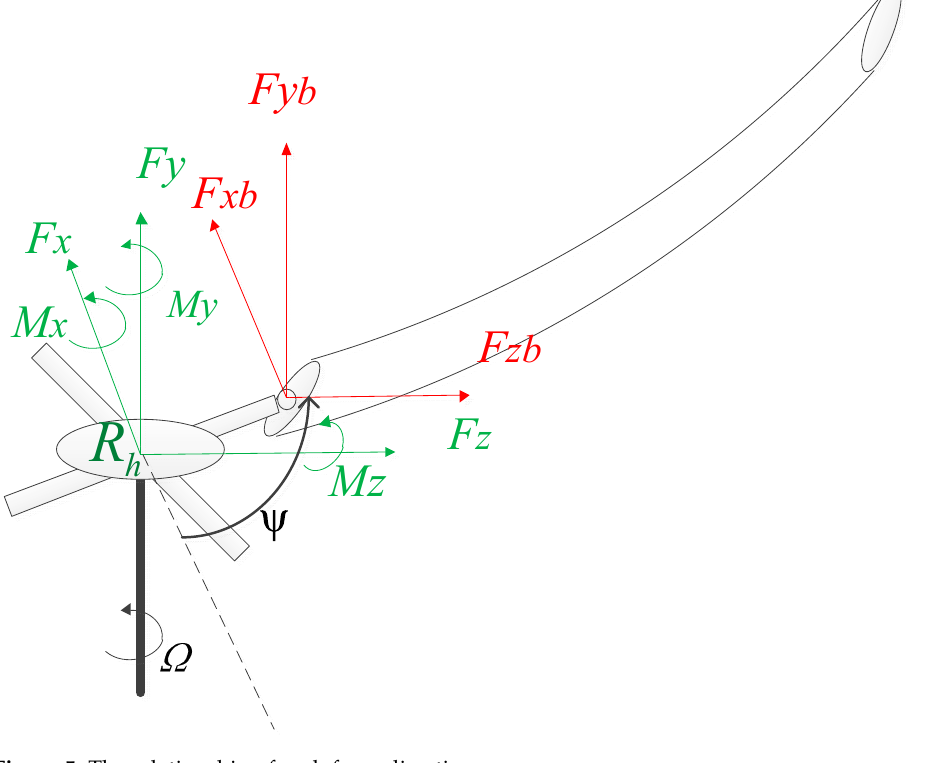
Figure 5. The relationship of each force direction.